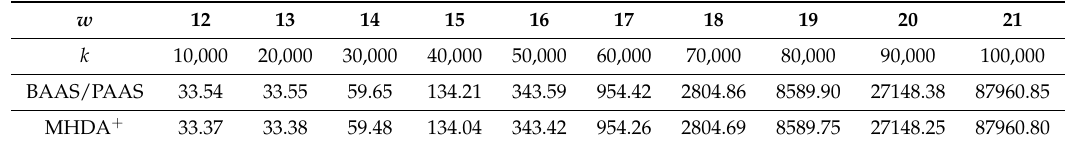
Table 6. List of error